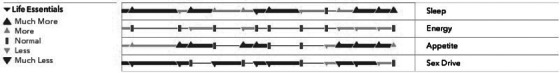
Life essentials.